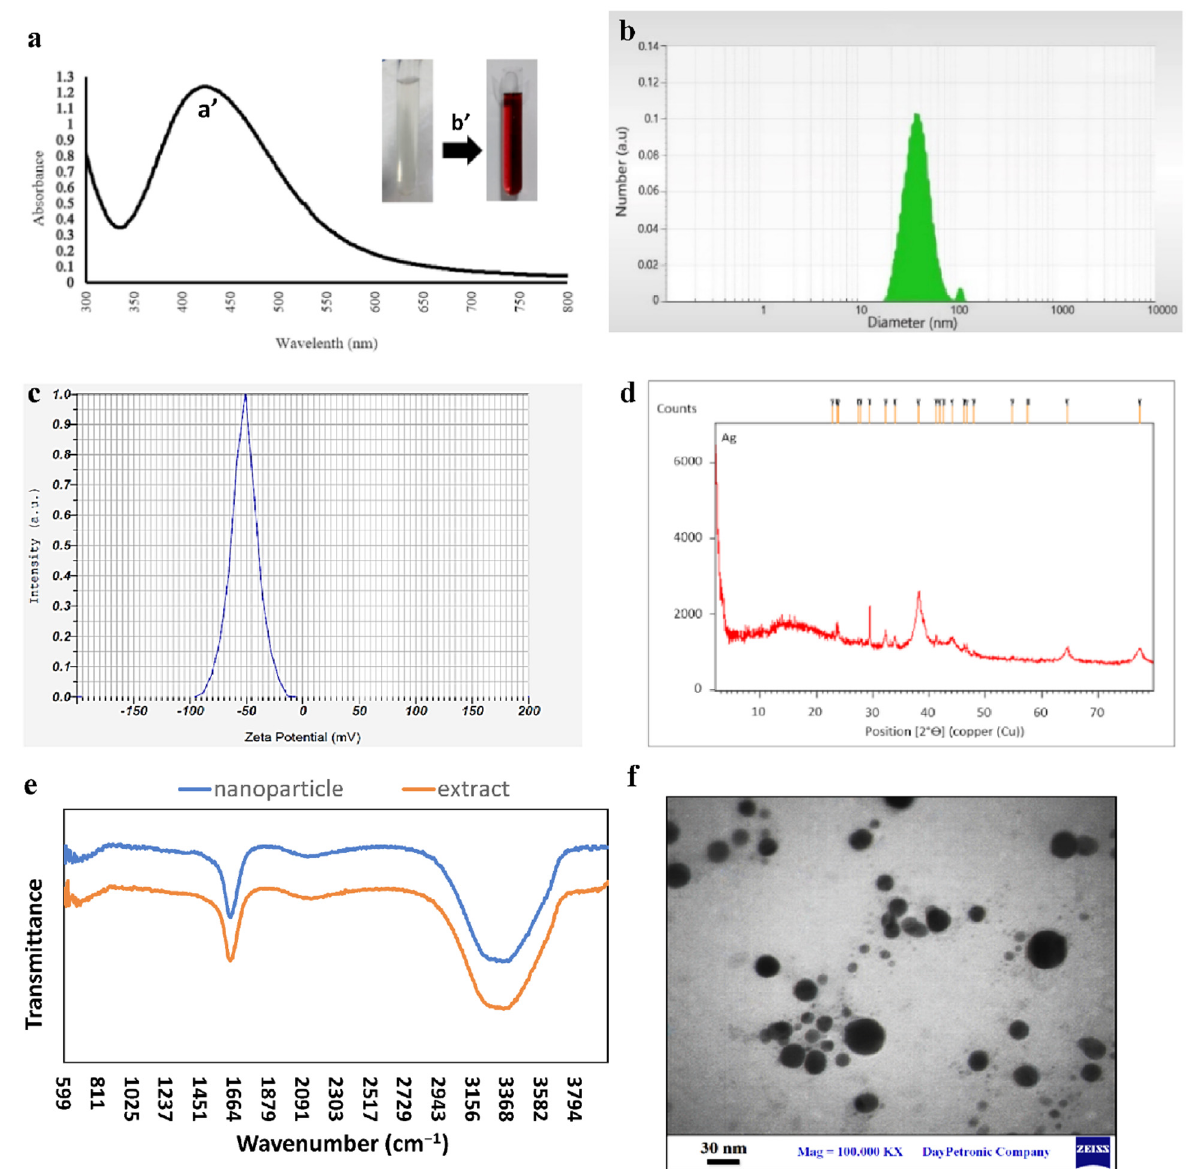
Figure 1. ( a ): UV-Vis spectroscopy of green synthesized SNPs ( a’ ). color change after the reaction was completed ( b’ ). ( b ): DLS results of green synthesized SNPs. ( c ): Zeta potential of green synthesized SNPs. ( d ): XRD analysis of green synthesized SNPs. ( e ): FTIR analysis of the extract and the SNPs with which synthesized. ( f ): Microscopic study of green synthesized SNPs by TEM.